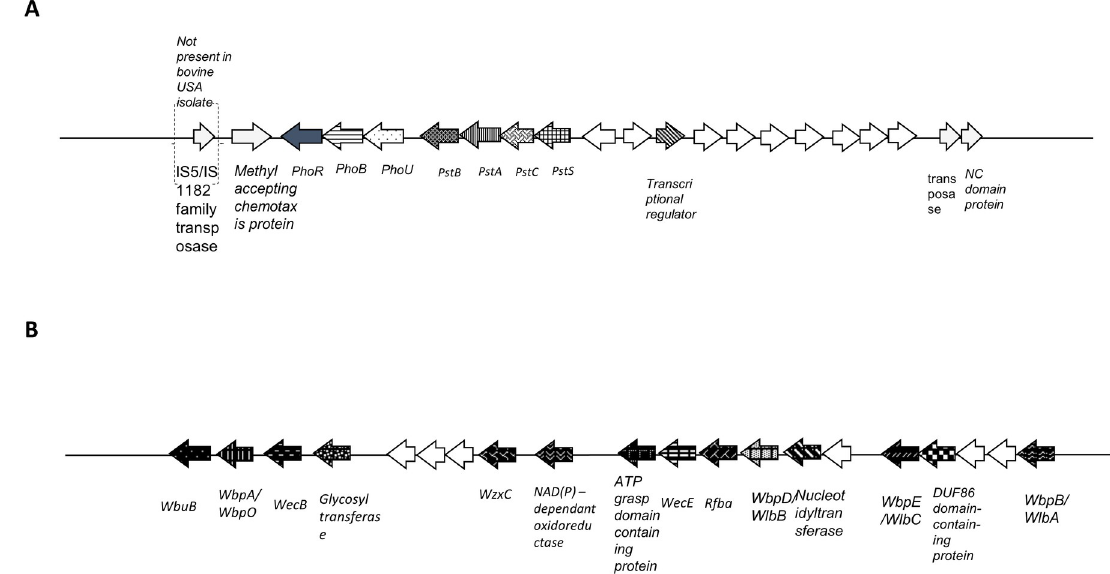
Fig 4. Genetic clusters unique to the bovine pathogenic Treponema phagedenis strains. The bovine T . phagedenis unique gene cluster contains two polycistronic operons for phosphate utilisation ( A ). All ORFs listed are present in UK, USA and Swedish T . phagedenis genomes and absent for human genomes except for area in dashed parentheses. The bovine T . phagedenis unique gene cluster containing a variety of genes associated with outer membrane production, nucleotide metabolism and oxidative stress ( B ). All ORFs present in UK, USA and Swedish T . phagedenis genomes and absent for human genomes. No mobile elements identified immediately surrounding these ORFs. ORFs not to scale. Arrows with solid white fill are hypothetical proteins.